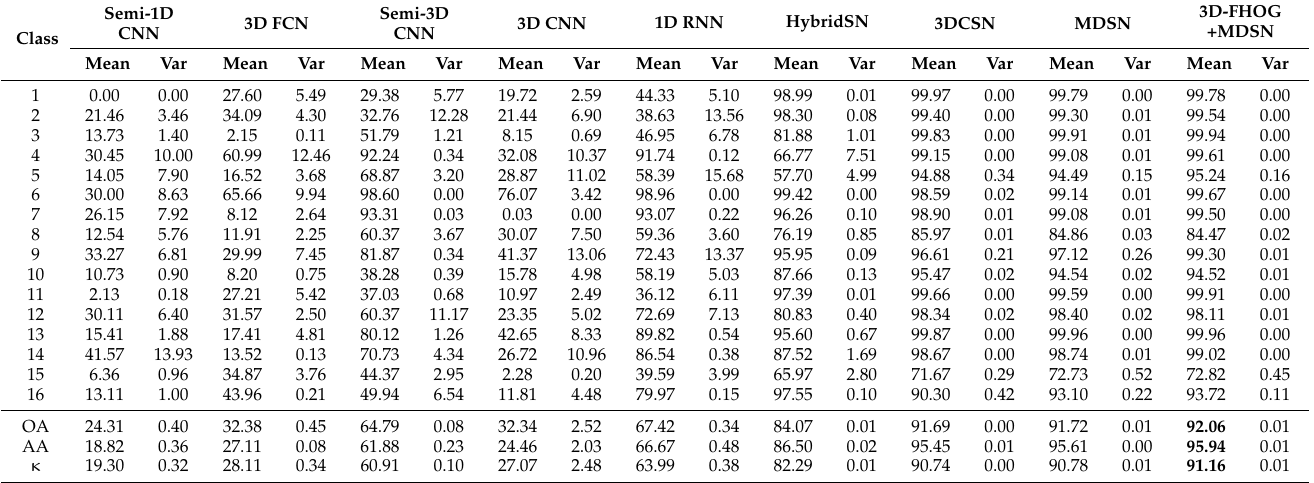
Table 10. Classification results (%) for eight different CNN-based methods and 3D-FHOG + MDSN on the test set of SA data set, with three labeled samples per class as training